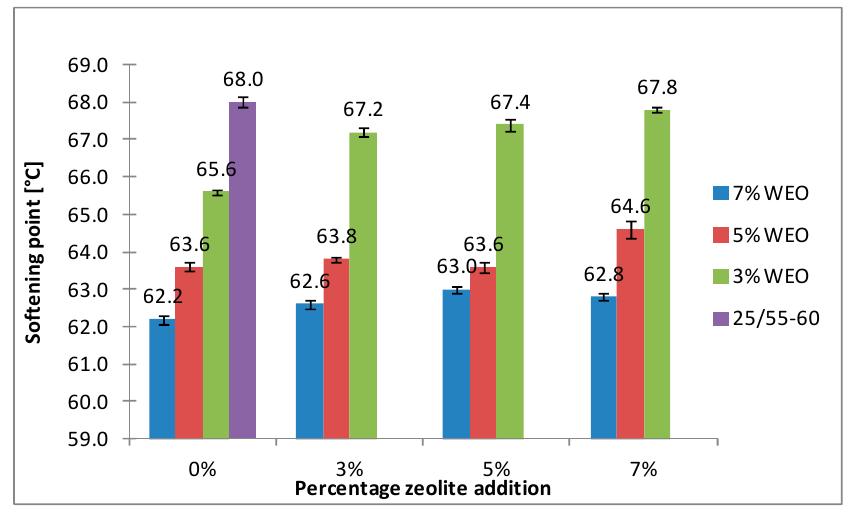
Figure 14. The results of penetration tests for the 25/55-60 asphalt with the addition of WEO and Na-P1 zeolite measured at 25 °C.